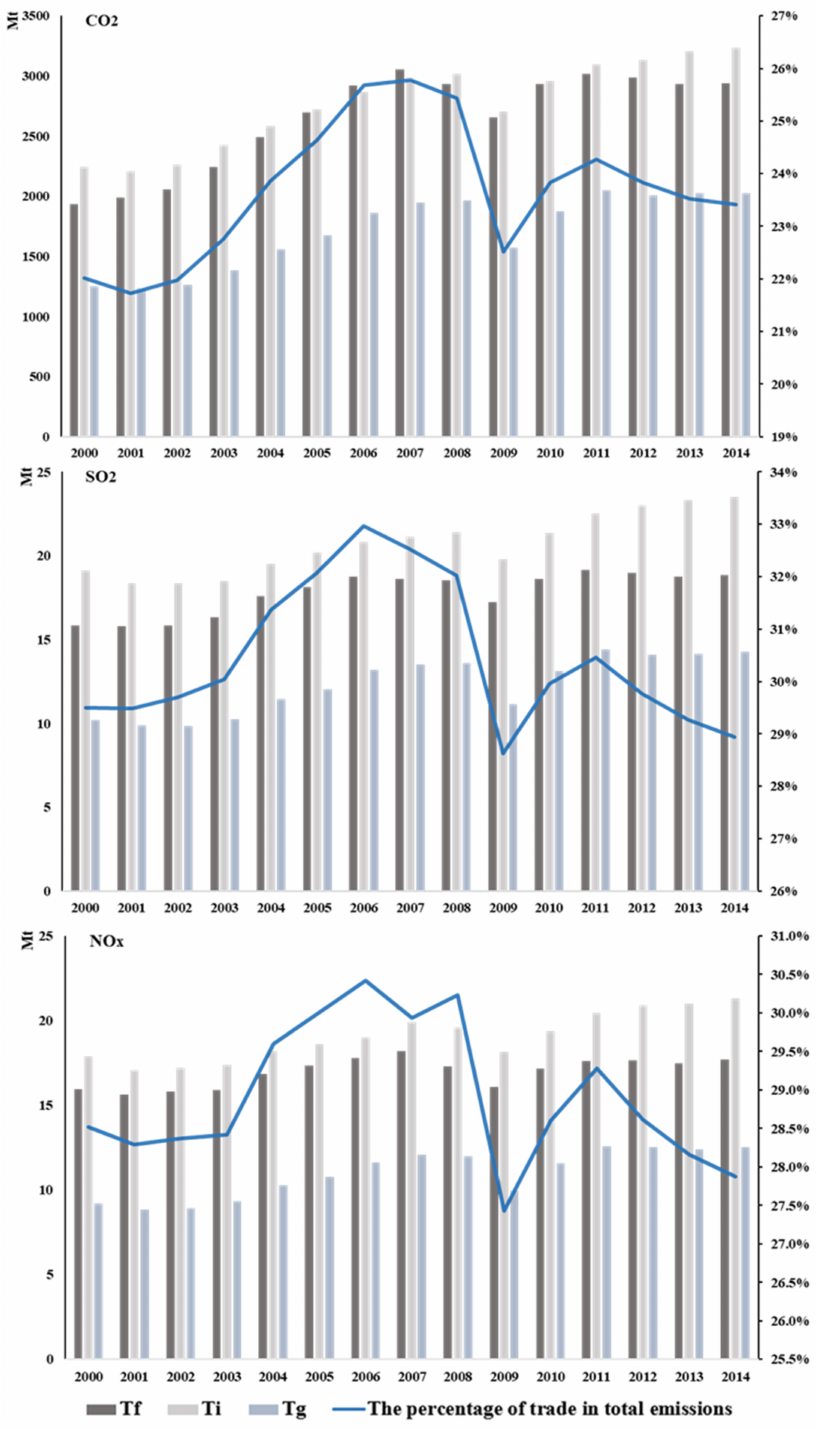
Figure 2. Changes in emissions under the three trade patterns in 2000–2014. The x-axis represents years; the left-hand-axis represents pollutants emissions under different trade patterns: Tf—final product trade; Ti—intermediate product trade in the last stage of production; Tg—the trade related to the global value chain. The right-hand axis represents the percentage of trade in total emissions. See Appendix C Table A3 for